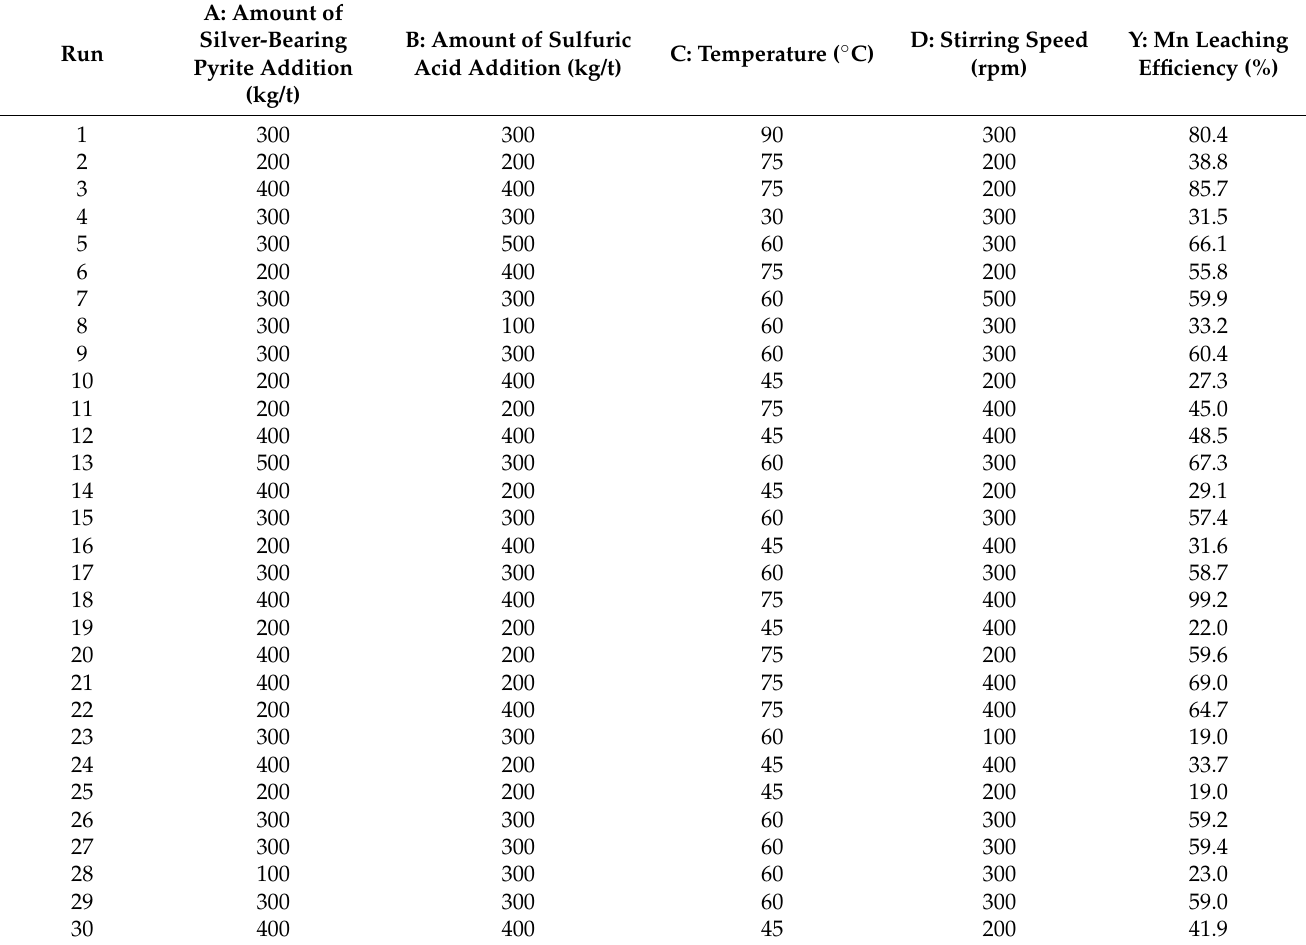
Table 4. Central composite design values for different experimental